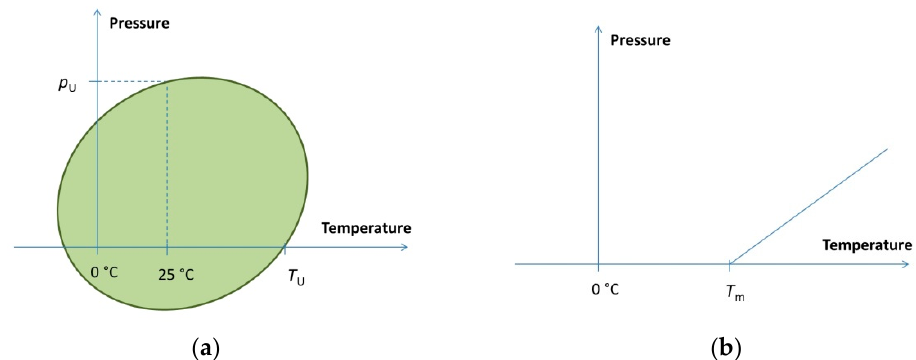
Figure 1. Pressure–temperature phase diagram types. ( a ) Elliptic phase diagram of proteins. Typical values are p U = 200… 700 MPa, T U = 50… 90 °C. ( b ) Linear phase boundary typical for lipid–water systems and for nucleic acid solutions. Typical slope for lipids is around 5MPa/°C. T m depends on the type and length of the chain and on the head group type. As an example, T m = 41 °C for DPPC.